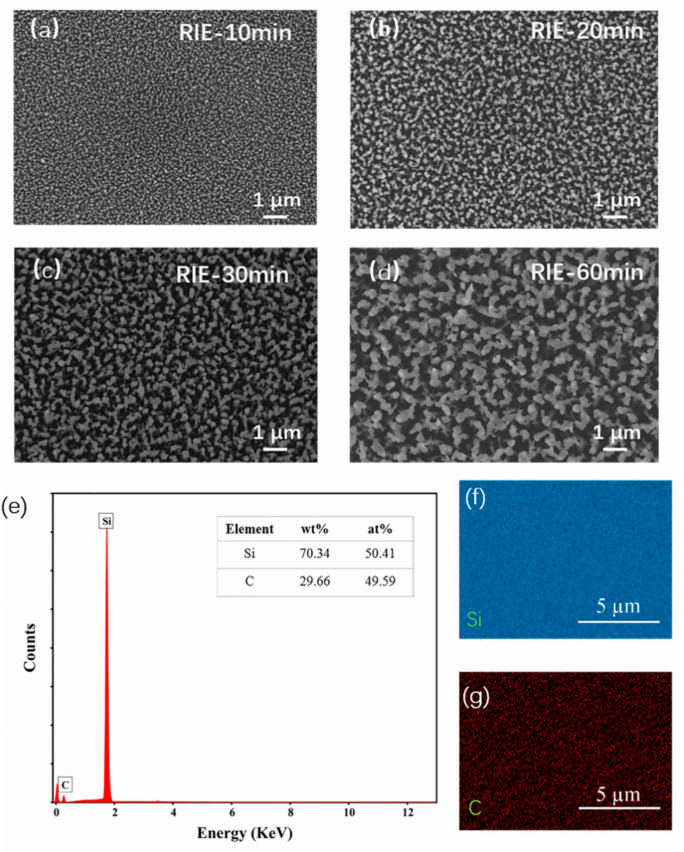
Figure 2. SEM images (plan view) of SiC nanoarrays prepared by RIE etching for ( a ) 10 min, ( b ) 20 min, ( c ) 30 min, and ( d ) 60 min, respectively (scale bar: 1 µ m). ( e ) Energy-dispersive X-ray (EDX) spectrum of nanoarrays etched for 20 min, the inset is the proportion of the chemical compositions. ( f , g ) EDX elemental mapping.